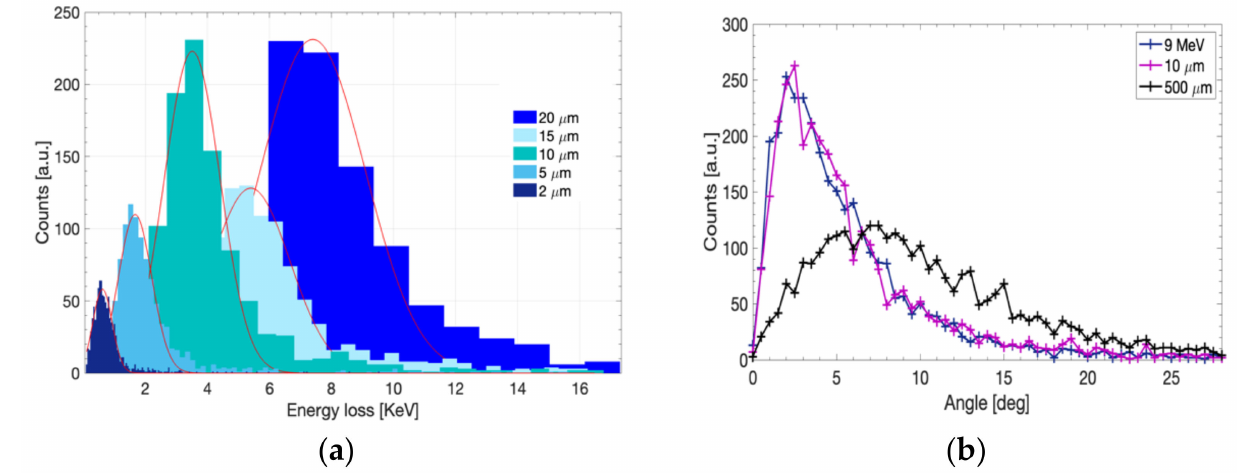
Figure 3. ( a ) Distribution of the energy deposited in the detector active layer for the five geometrical configurations under study with 9 MeV electron incident beam. Gaussian fit performed on the different distributions are also shown. ( b ) Angular distribution obtained after 10 µ m thick (purple line) and 500 µ m thick (black line) SiC detector traversed by a 9 MeV electron beam having an initial angular distribution shown in the figure with the blue